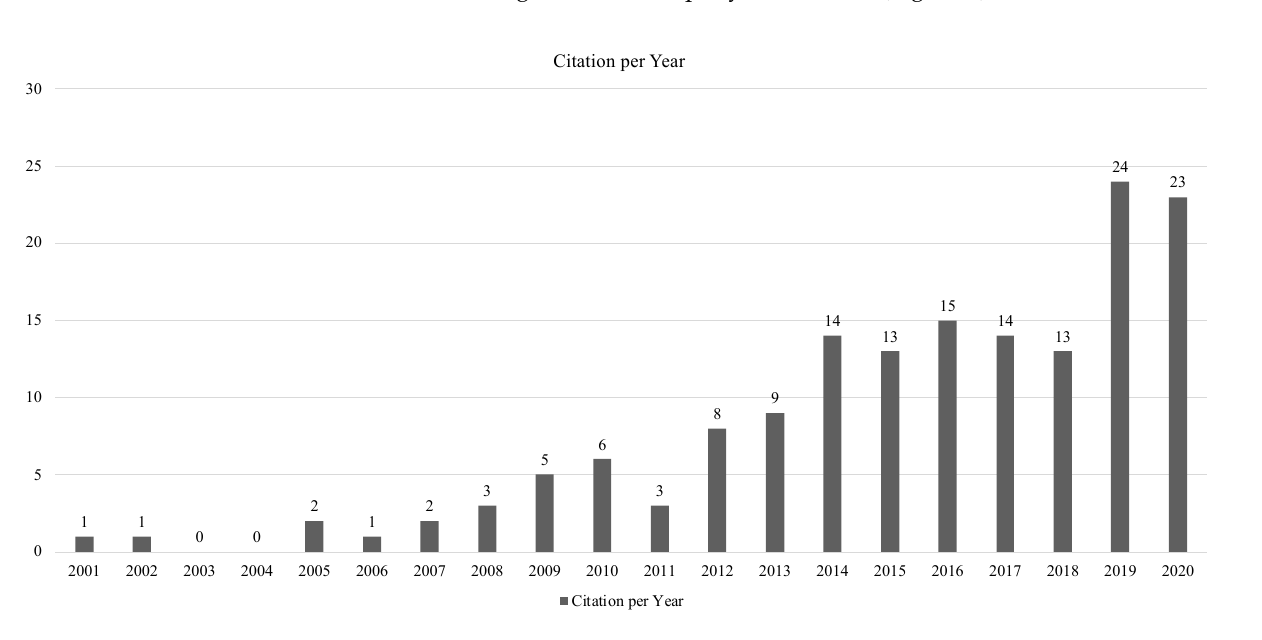
Figure 4. Evolution of the literature over the time.